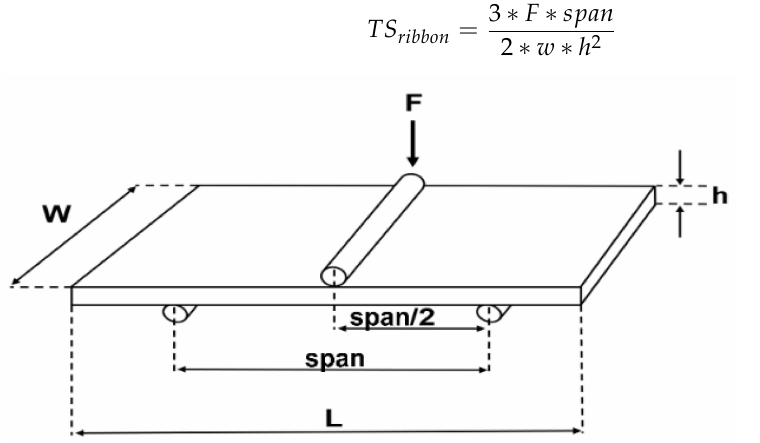
Figure 3. Illustration of a three-point beam fracture test for ribbons with the ribbon width ( w ), ribbon height ( h ), span of loading ( span ), ribbon length ( L ) and force at tensile failure ( F